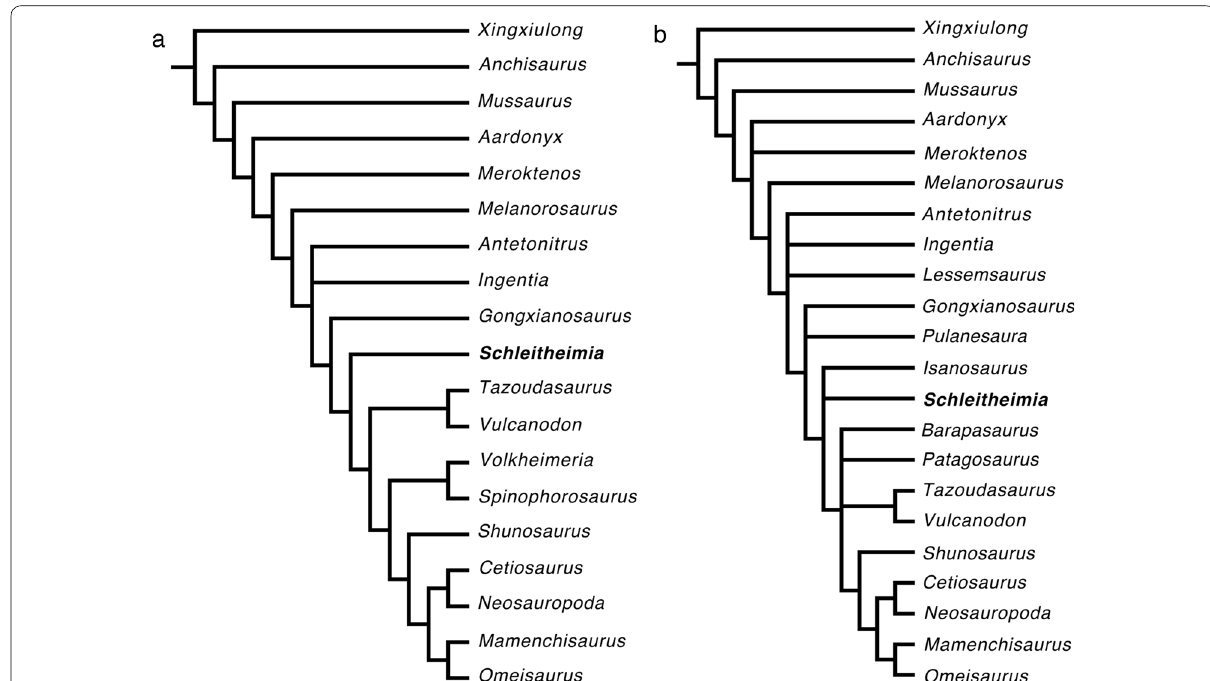
Fig. 22 Separate phylogenetic analysis of the holotype ilium only ( a ) and the referred material of Schleitheimia , showing congruent results ( b ). Only simplified sauropodiform interrelationships are shown (see Additional file 2: Figure S2 and Additional file 3: Figure S3 for complete strict consensus